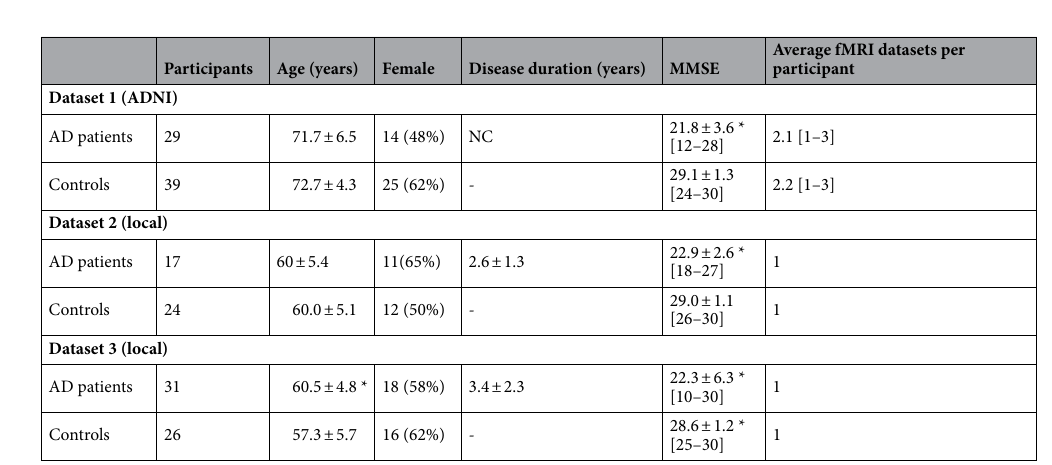
Table 2. Participant demographics. Descriptive demographic characteristics of the groups. Values represent mean ± SD or N (%). [Range]. NC = Not collected, multiple datasets. MMSE = Mini Mental State Examination (maximum total score is 30). * patients versus controls, where P <